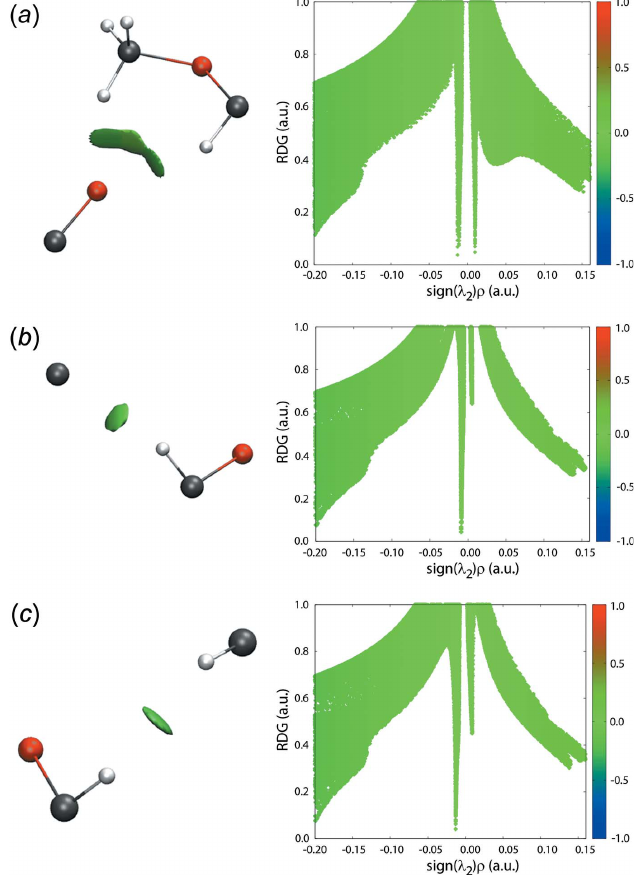
Figure 7 Non-covalent interaction plots for intermolecular interactions between ( a ) methyl-C7- and methine-C—H atoms, and the carbonyl-O2 atom, ( b ) chlorobenzene-C6 and methyl-H7 C atoms and ( c ) methyl-H7 B and phenyl-H14 atoms.